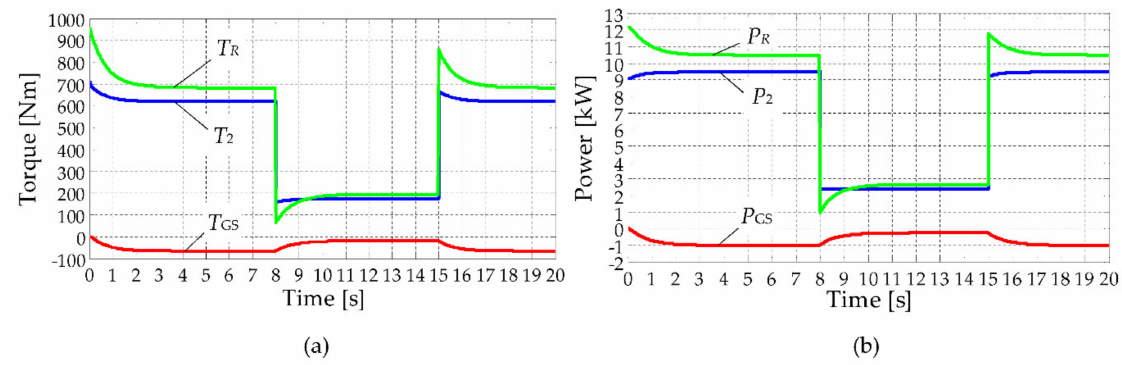
Figure 8. The dynamic distribution on gear 2 and the generator stator GS of the: ( a ) torque and ( b ) mechanical power generated by the wind rotor R